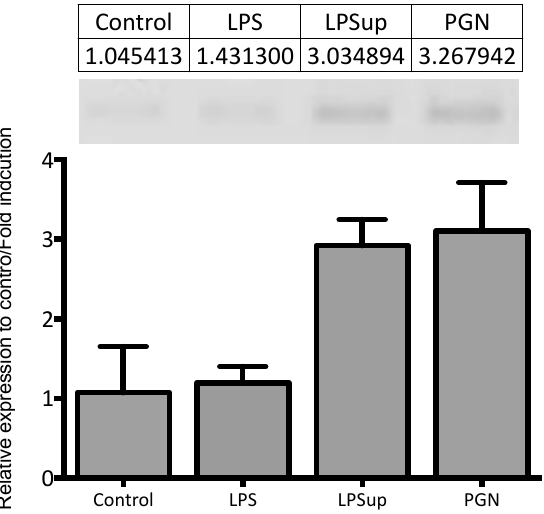
Figure 7. Quantitative RT-qPCR analysis of tumour necrosis factor- α (TNF- α ) mRNA abundance in primary monocyte/macrophage-like cell cultures stimulated during 12 h with LPS, ultrapure LPS and PGN (10 μ g/mL).